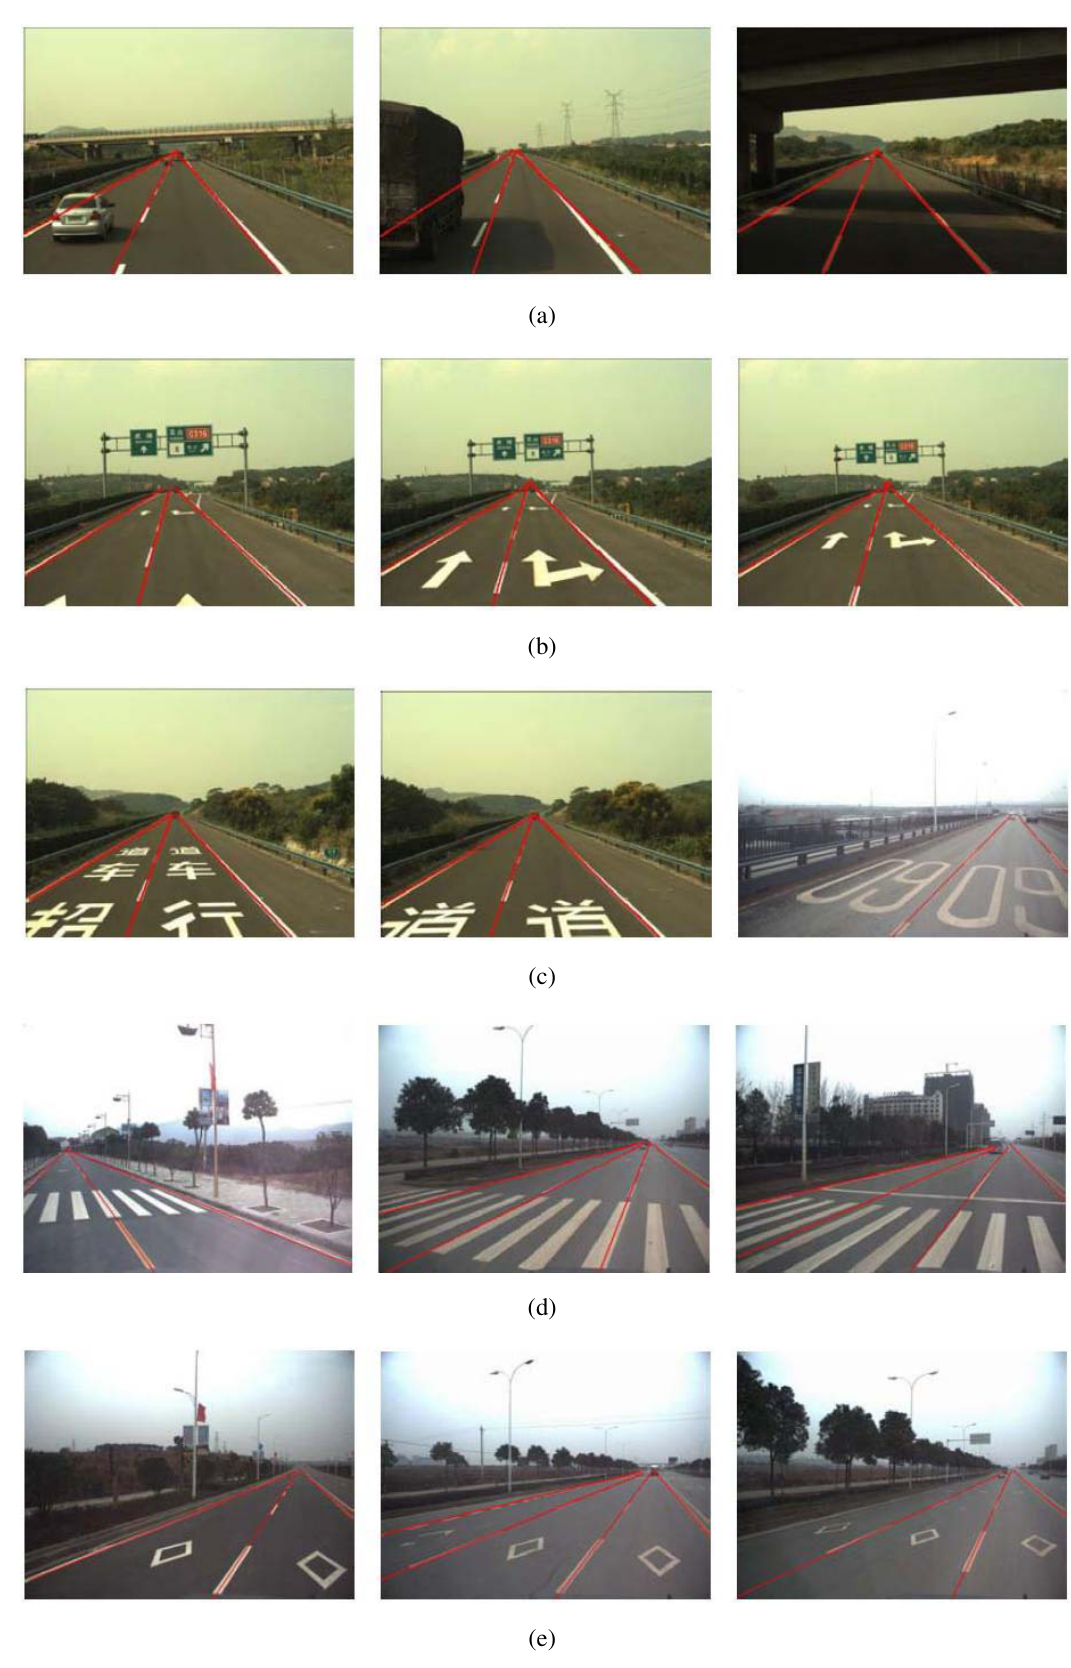
Figure 12. Some examples of lane detection